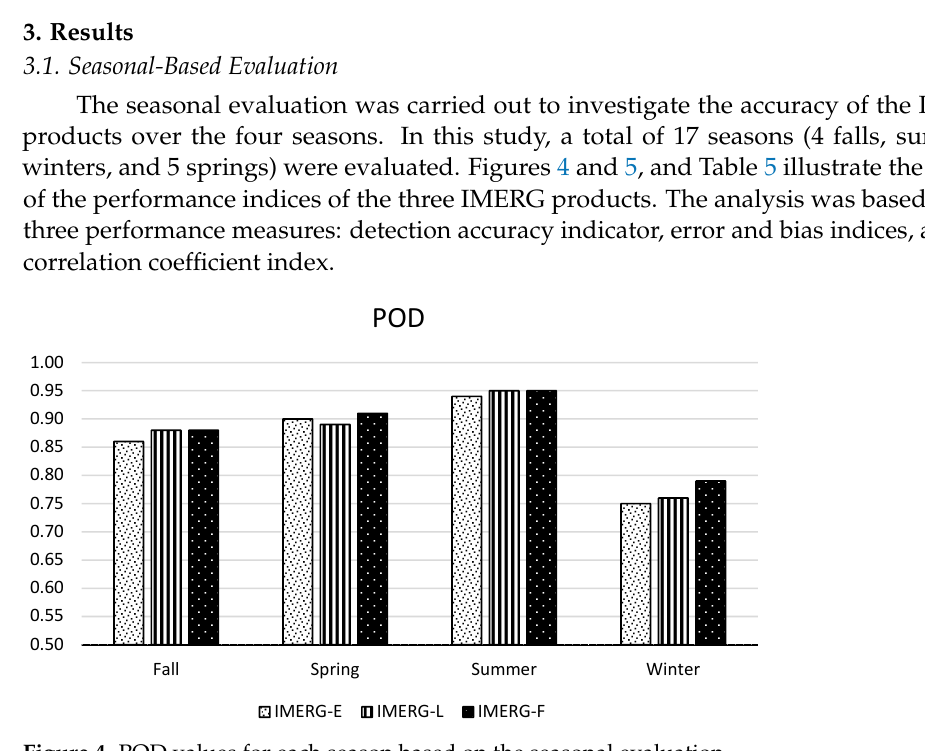
Table 5. Error and BIAS indices based on the seasonal evaluation.